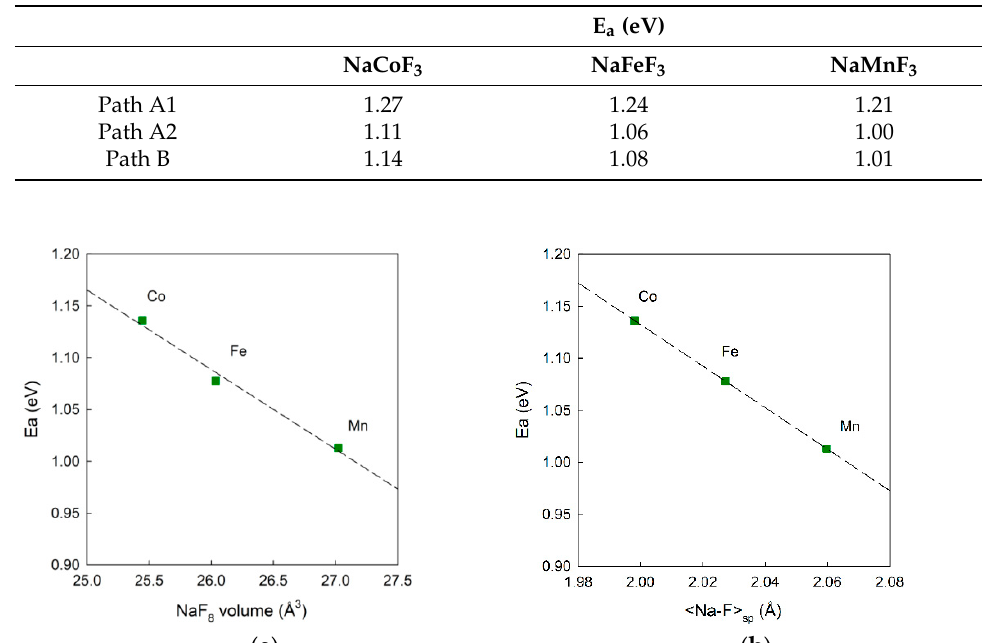
Table 1. Calculated activation energies (E a ) for Na-ion diffusion in the NaMF 3 system (M = Co, Fe, and Mn), according to the paths presented in Figure 8.